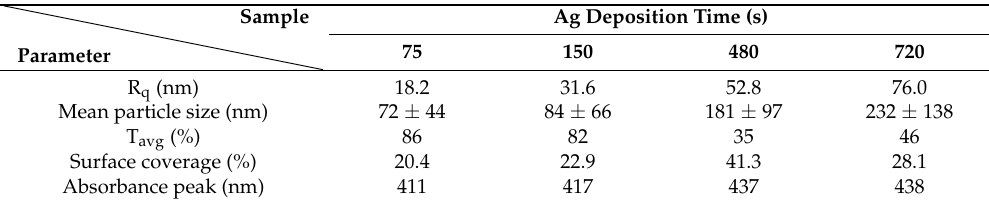
Figure 1. Surface roughness of: ( a ) the as-deposited Ag seed layer; and ( b – e ) the Ag seed layer deposited for 75, 150, 480, and 720 s, respectively, and then annealed at 500 °C for 1 min under nitrogen ambient. Table 1. Surface roughness (R q ), mean particle size, average transmittance (T ave ), surface coverage, and absorbance peak of the Ag seed layer deposited for various time after annealed at 500 °C for 1 min under nitrogen ambient.